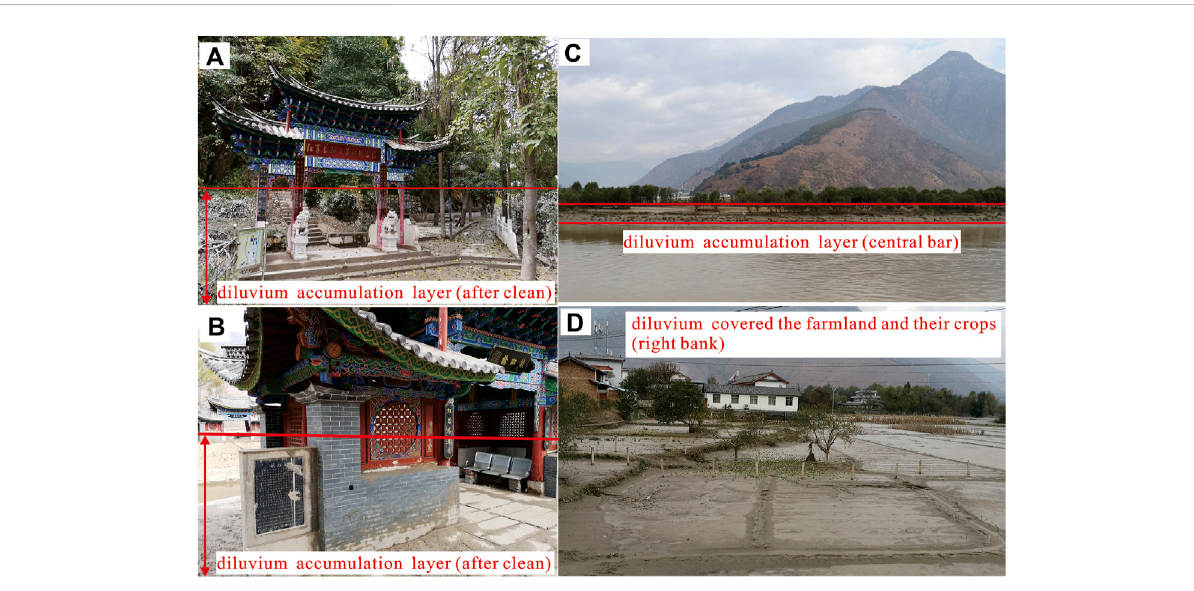
FIGURE 4 Accumulationofdiluvium invariouslocations intheFirstBendarea(Shigutown)oftheJinshaRiver. (A,B) Diluvium covered thedwellingsatthe right bank of the Jinsha River; photographs were taken after cleaning. (C) Diluvium outcropped at the central bar after the mega fl oods disappeared. (D) Mega fl ood outburst sediments covered the farmlands and their